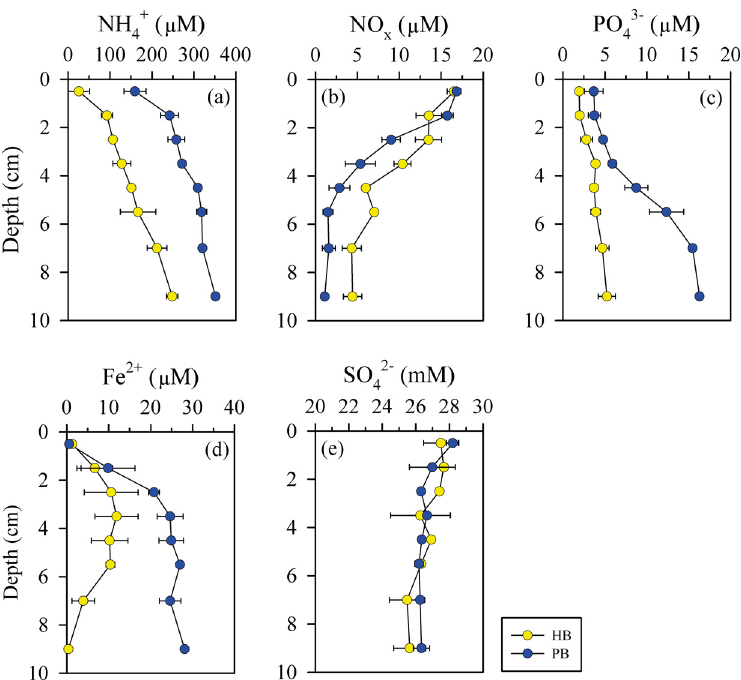
Fig. 2. Vertical profiles of NH 4+ , NO x , PO 43− , Fe 2+ , and SO 42− in pore water. Horizontal bars indicate SE. HB: highly bioturbated; PB: poorly bioturbated